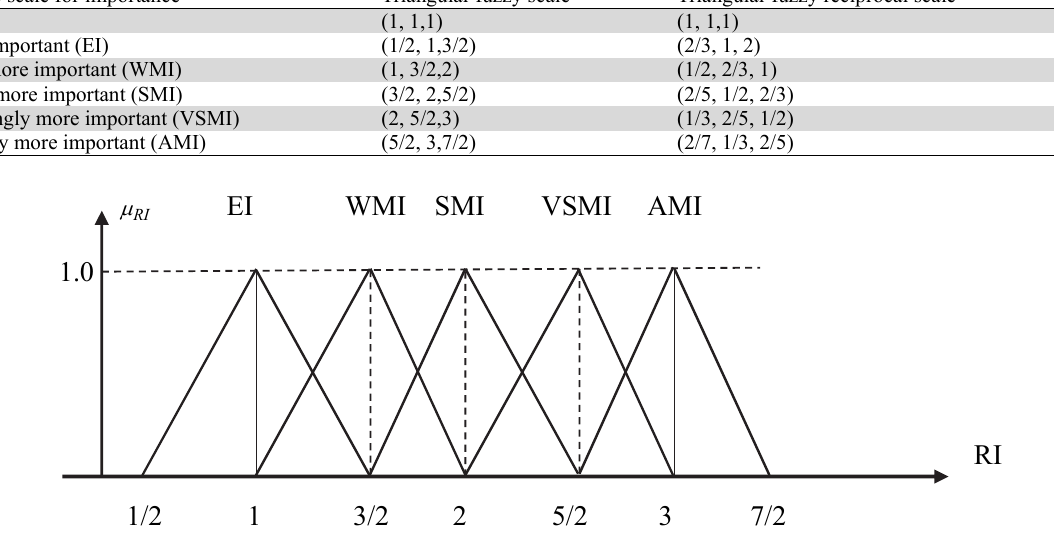
Fig. 3. Linguistic scale for relative importance (Kahraman et al.,